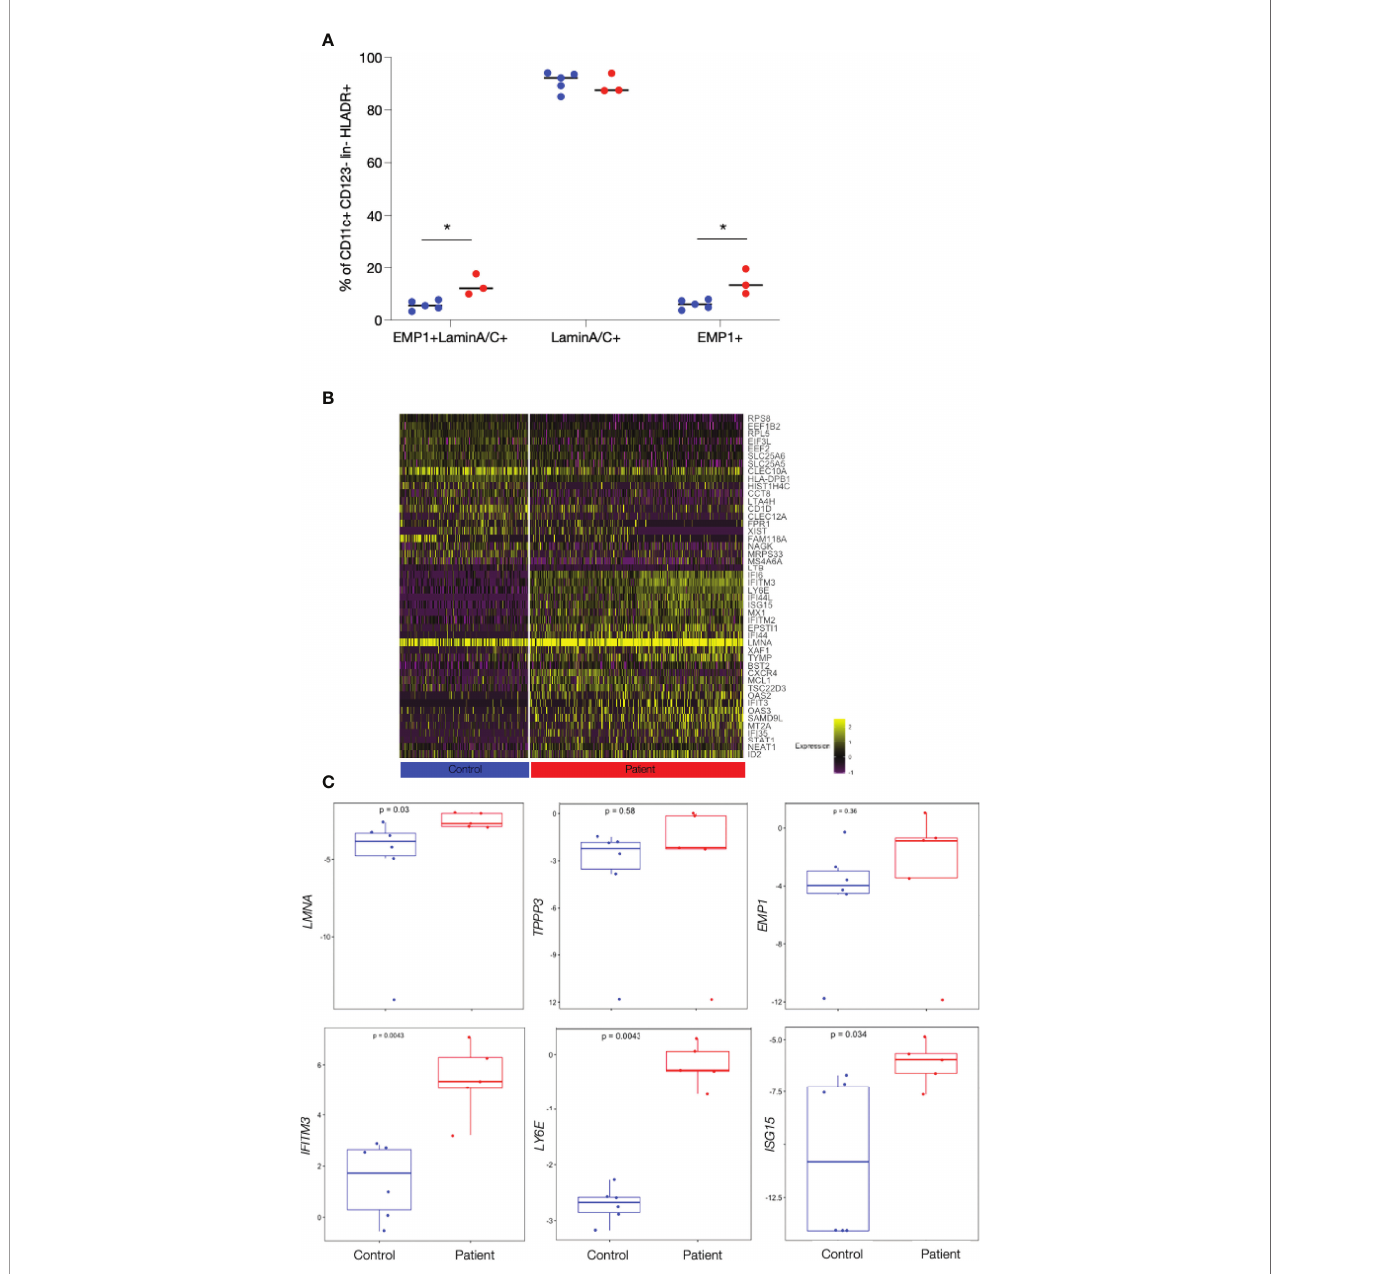
FIGURE 3 | Enrichment of patient ’ s cells and con fi rming patient speci fi c gene expression in a CD11c + EMP1 + cell subset isolated by FACS. (A) Frequency of Lamin A/C + , EMP1 + and of Lamin A/C + EMP1 + (DC2-E) cells from patients and controls in CD11c+CD123 - cells determined by FACS analysis. Controls are shown as blue and patients as red dots. Comparisons with signi fi cance are marked with an *(p-value< 0.05, Mann-Whitney Test). (B) Heat map showing the top 25 genes differentially expressed between patients and controls in DC2-E cells found by scRNAseq (note that only 21 genes were found upregulated in controls). Genes upregulated and with entries in Interferome are shown in red. The bar below the heat map shows patient ’ s cell in red (right) and control cells in blue (left). Graduation of expression ranges from purple (absent) to yellow (high). (C) Boxplots showing qPCR quanti fi cation of exemplary, patient speci fi c genes (found by scRNAseq to be differentially expressed in patients and controls) in sorted CD11c + CD123 - EMP1 + cells batches from patients and controls. The gene analysed is shown on the y-axis and p-values are shown within the plots. Measurements considered to be with signi fi cance show a p-value< 0.05, Wilcoxon Rank Sum